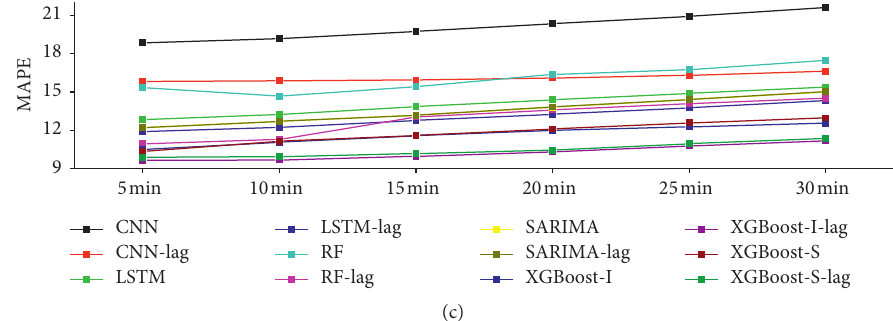
Figure 16: Comparison of traffic prediction performance of different methods in short-term 5-minute time steps of mean RMSE, MAE, and MAPE.